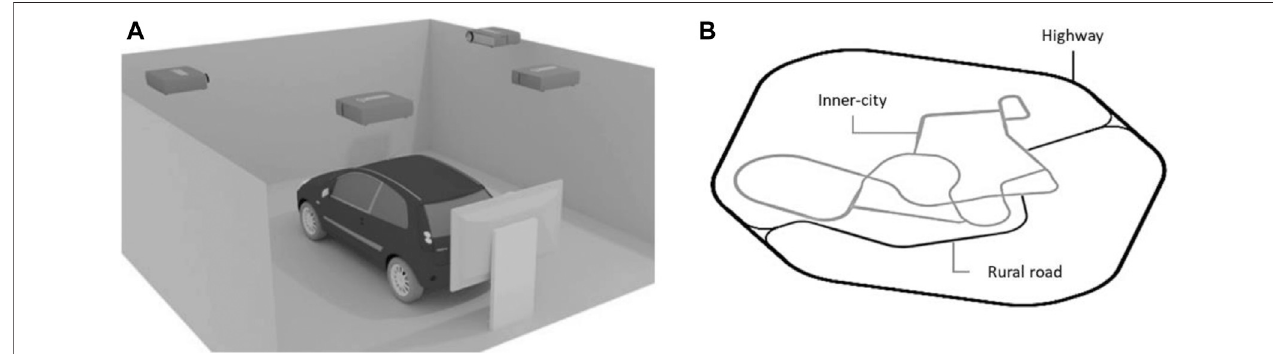
FIGURE 4 | (A) Schematic representation of the driving simulator used. The four projectors on the ceiling display the virtual environment on the walls around the vehicle. The monitor behind the vehicle is used for both the rear view and the re fl ection of the image in the interior mirror. (B) Sketch of the baseline driving scenario consisting of inner-city roads, rural roads, and highways. The driving scenario in T2 used the same scenario but limited to highway only.